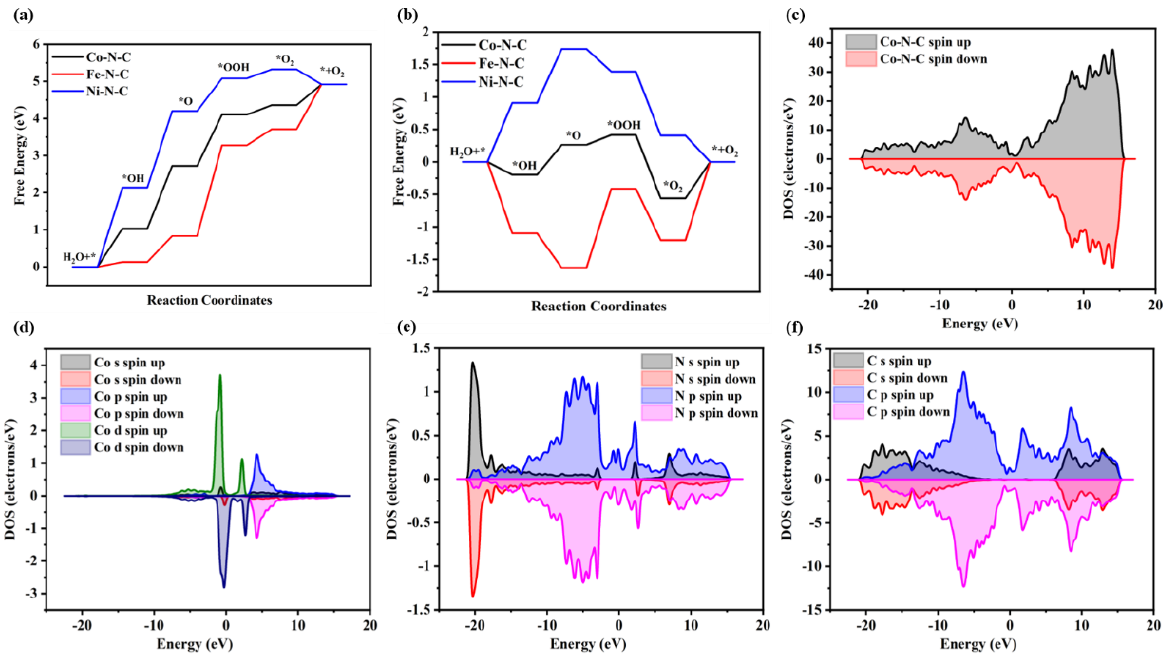
Figure 6. ( a ) Gibbs free energy variation in different aerogels for each of the OER primitive processes. ( b ) Gibbs free energy variation in different aerogels in each primitive process of OER (U = 1.23 V). ( c ) The total density of states, ( d ) partial density of the state of Co atom, ( e ) partial density of the state of N atom, and ( f ) partial density of the state of C atom of the Co-N-C.